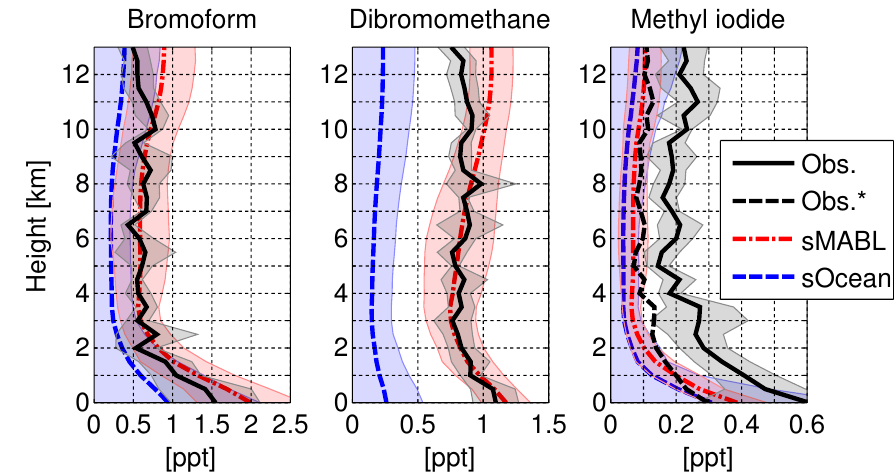
Figure 10. Mean FT mixing ratios (solid lines) and 1 standard deviation (shaded areas) from in situ and flask observations on R/A Falcon (Obs., black) vs. simulated mean FT mixing ratios from MABL air (sMABL, red) and oceanic emissions (sOcean, blue) observed by R/V Sonne . R/A Falcon in situ observations have been adjusted for CH 3 I (Obs. ∗ , dashed black) according to measurement deviations during the meetings of R/V Sonne and R/A Falcon (Table 2; Sect.